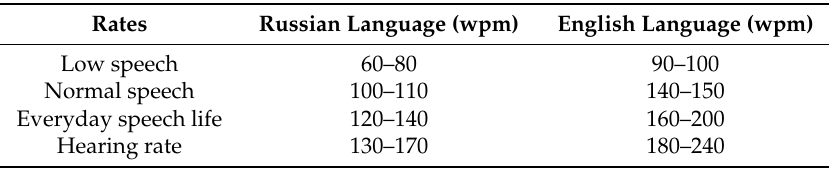
Table 2. Differences between speed and hearing rate in